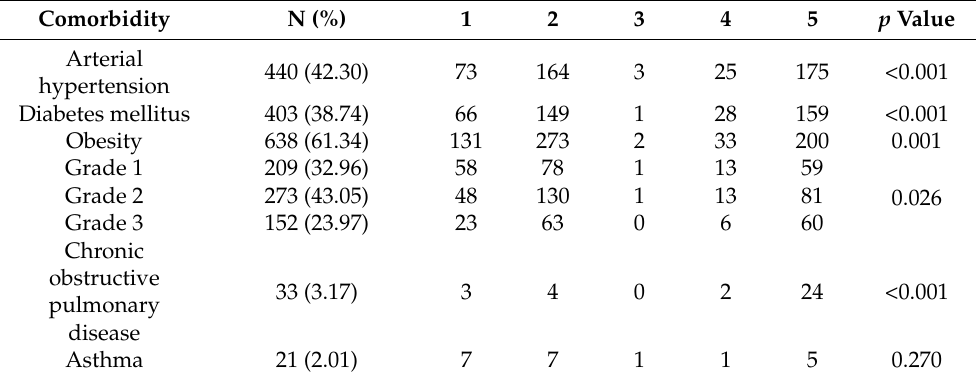
Table 5. Outcomes according to previous